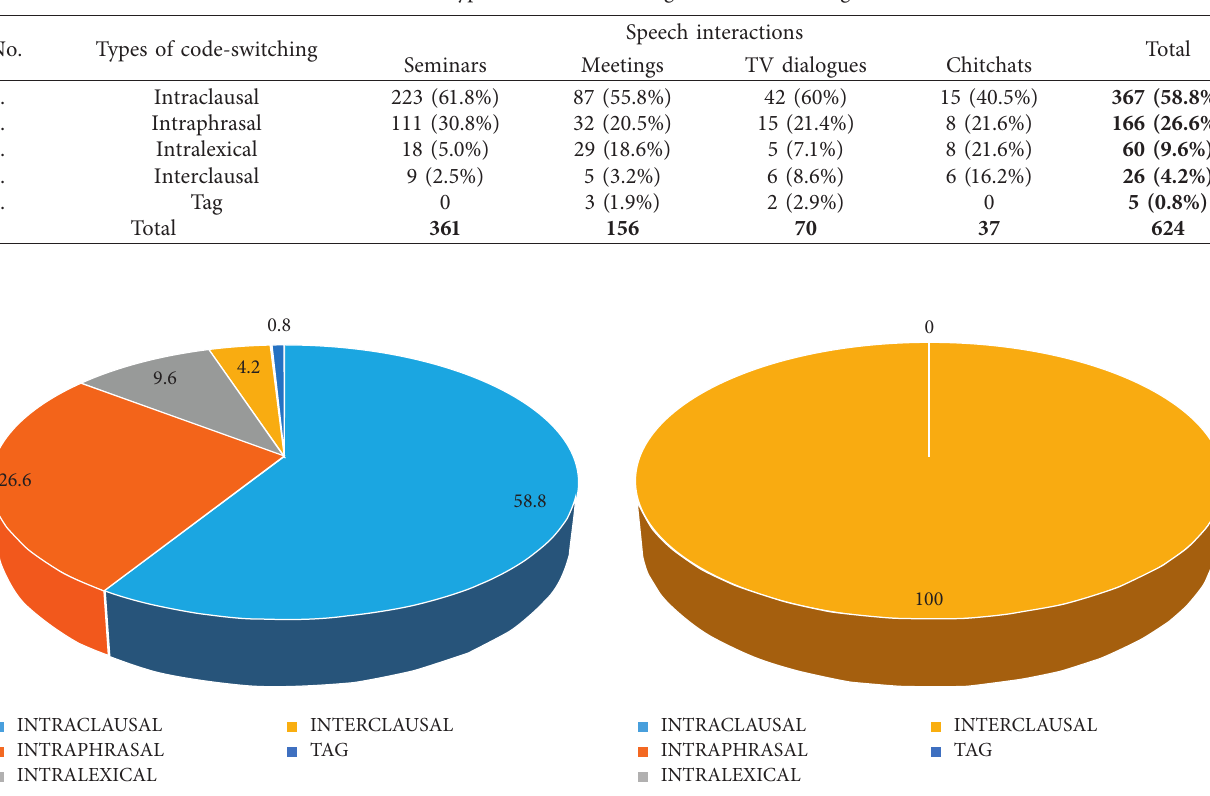
Figure 4: The dominant types of code-switching of EICS.